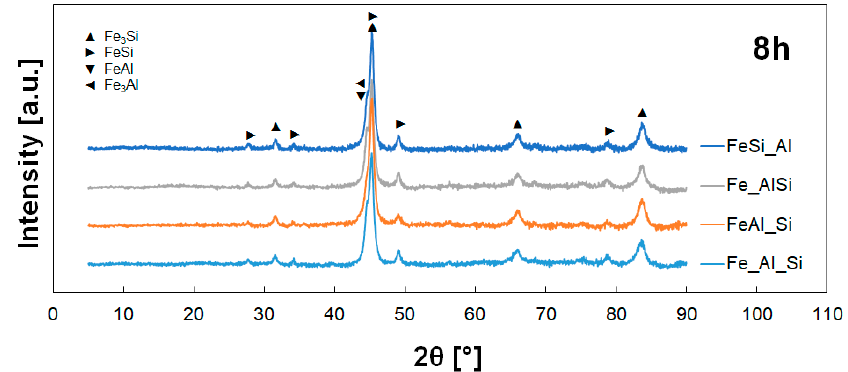
Figure 7. Phase composition of the powder mixtures in different stages of mechanical alloying.